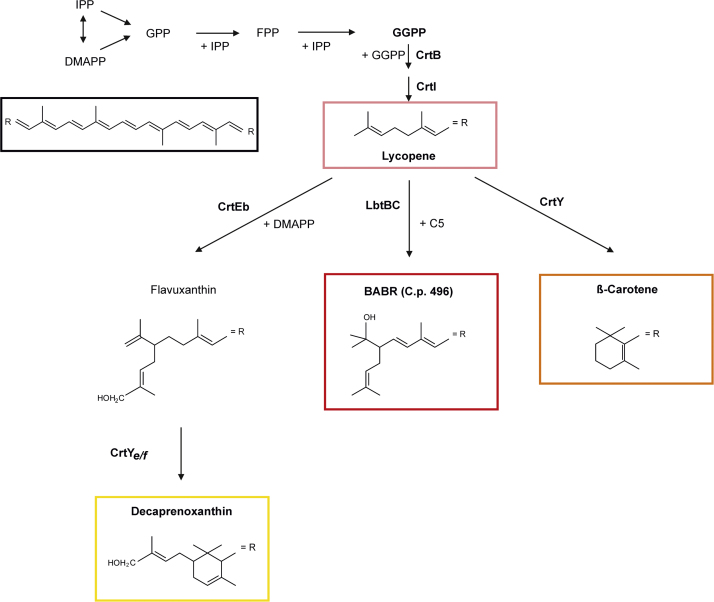
Scheme of carotenogenesis inC. glutamicumand engineered pathway leading to non-native carotenoids. The native pathway of decaprenoxanthin biosynthesis initiating with isopentenyl pyrophosphate via lycopene is depicted next to the introduced pathways leading to β-carotene and bisanhydrobacterioruberin (BABR), respectively. CrtEb, endogenous lycopene elongase; CrtYe/f, endogenous carotenoid C45/C50 ɛ-cyclase; LbtBC, lycopene elongase from Dietzia sp. CQ4; CrtY, lycopene cyclase from Pantoea ananatis.